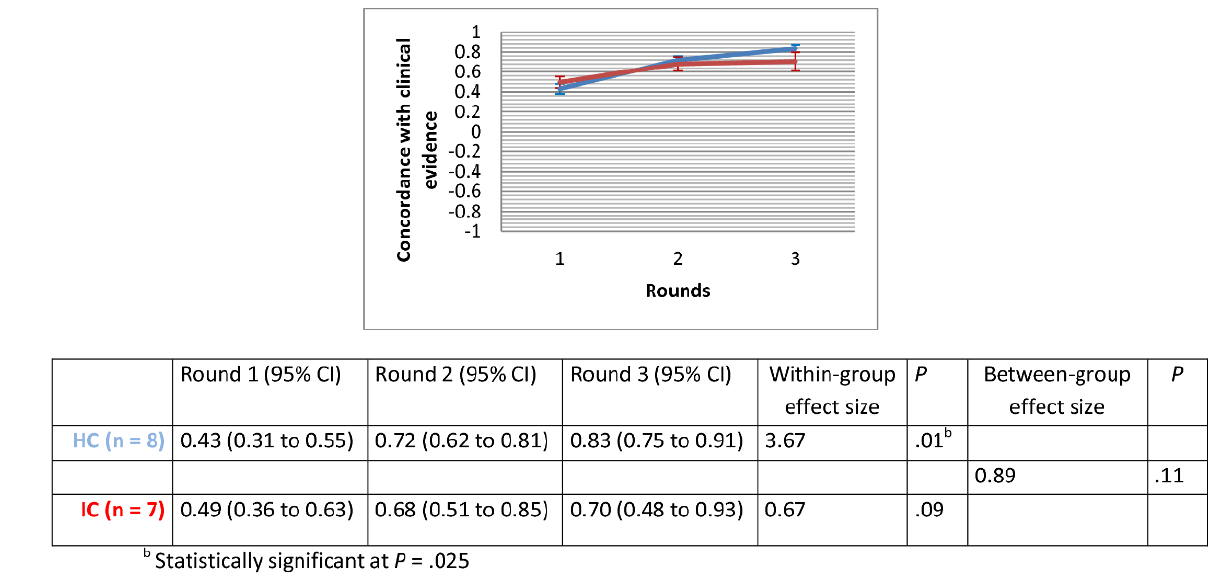
Figure 11. Concordance with clinical evidence for the drug use